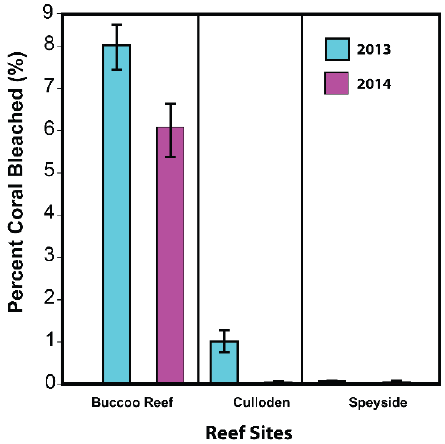
Figure 7. Percentage coral bleaching observed from the Reef Condition Monitoring Program (RECON) surveys conducted in September 2013 and September 2014 at Buccoo Reef, Culloden and Speyside.